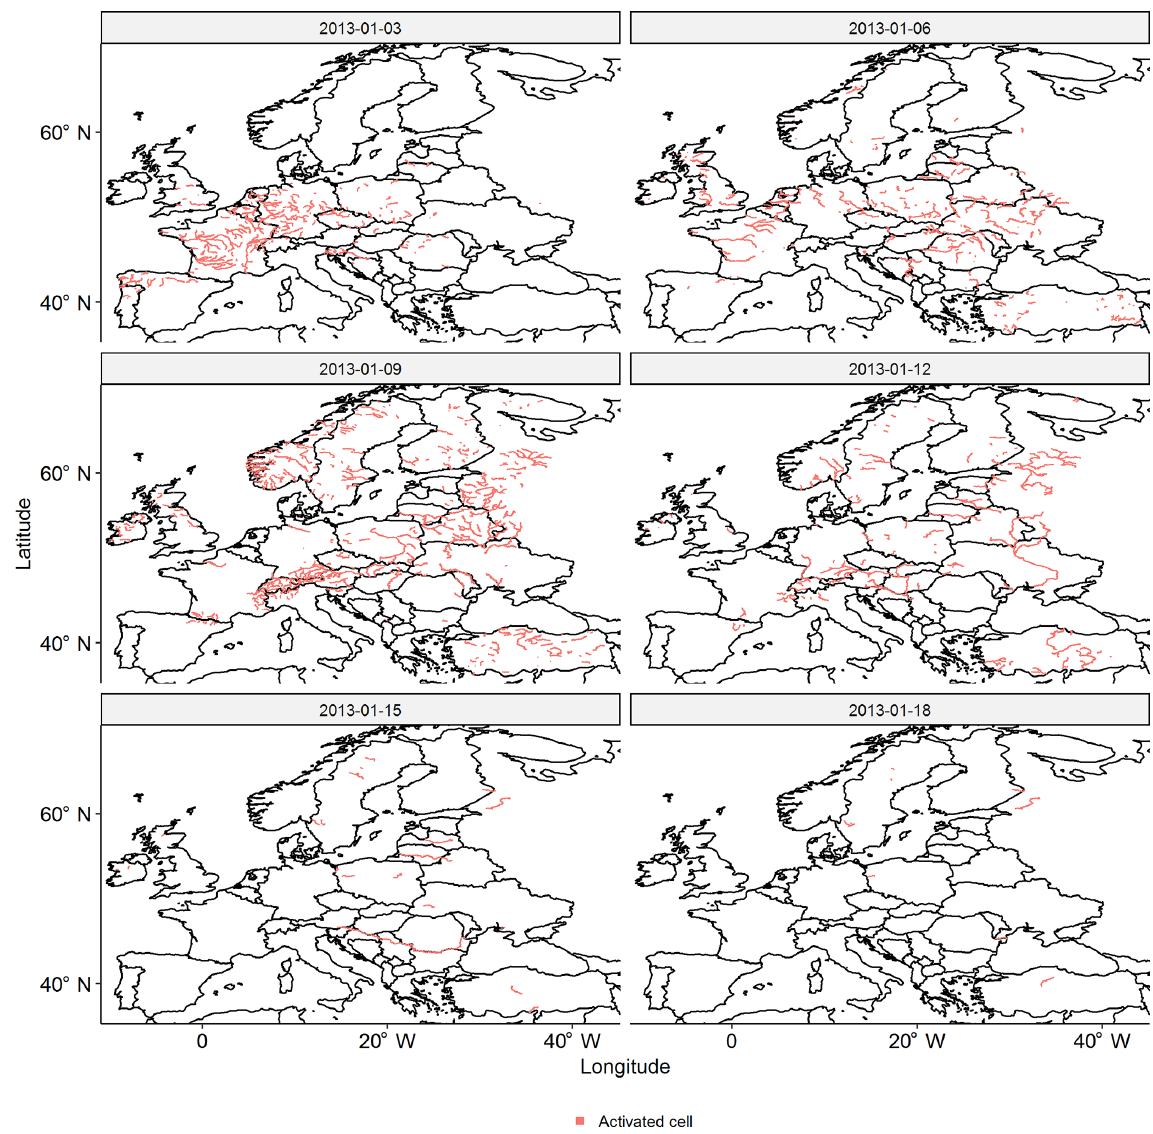
Figure 5. Daily snapshots of a Pan-European event with a large spatial extent. Date format is